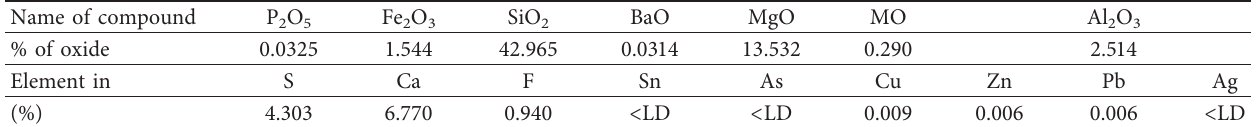
Figure 2: X-ray diffraction patterns of Gh-B. Table 1: Chemical composition of Gh-B.